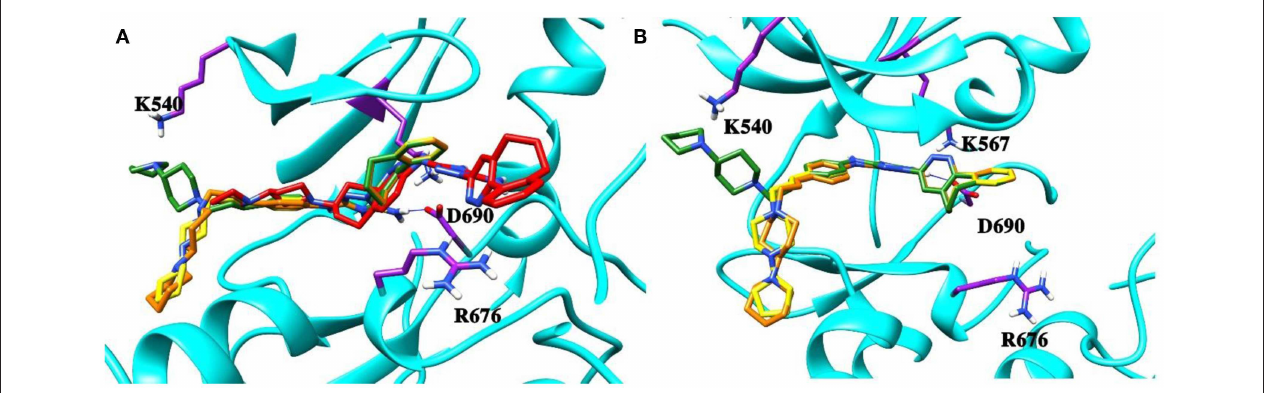
FIGURE 3 | (A) The superposition of the top four out of best 10 R428 analogs according to the MOE and GOLD docking results. The compound R428_1 is shown in red , the compound R428_2 is shown in orange , the compound R428_3 is shown in yellow , and the compound R428_4 is shown in green . The backbone of the kinase is represented as a cartoon and shown in cyan ; the key residues inside the pocket are highlighted in purple . The hydrogen bond between the R428_2, R428_3, and R428_4 compounds and D690 is marked as a blue line . (B) Superposition of the R428_2, R428_3, and R428_4 compounds for a better representation of their conformational coincidence.